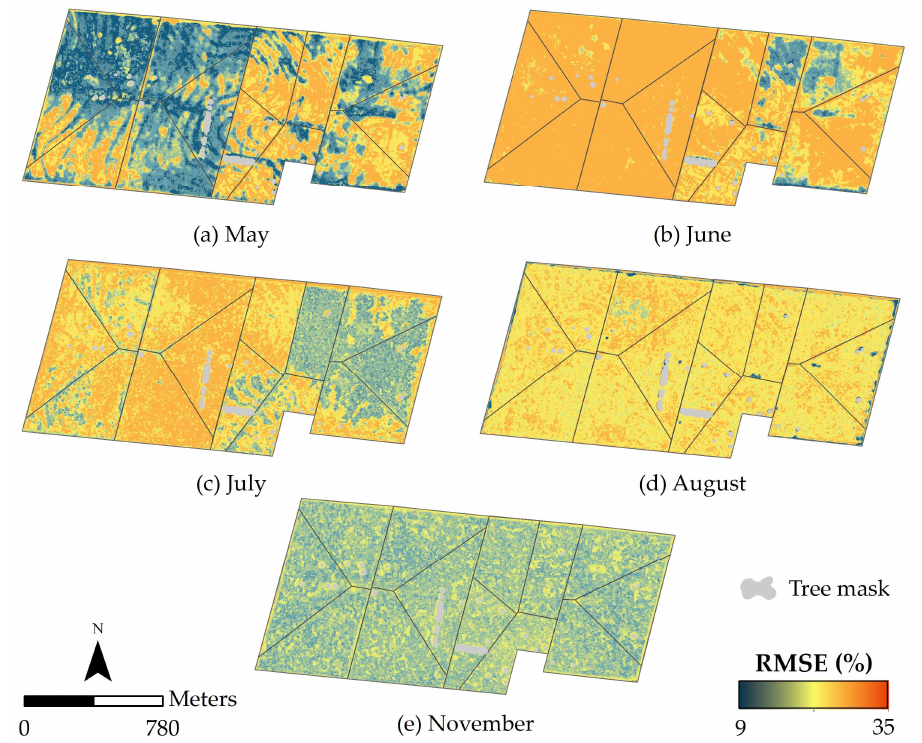
Figure 11. Estimated relative RMSE uncertainty (in %) maps for the canopy height (CH) estimation in the months of May ( a ), June ( b ), July ( c ), August ( d ), and November ( e ).